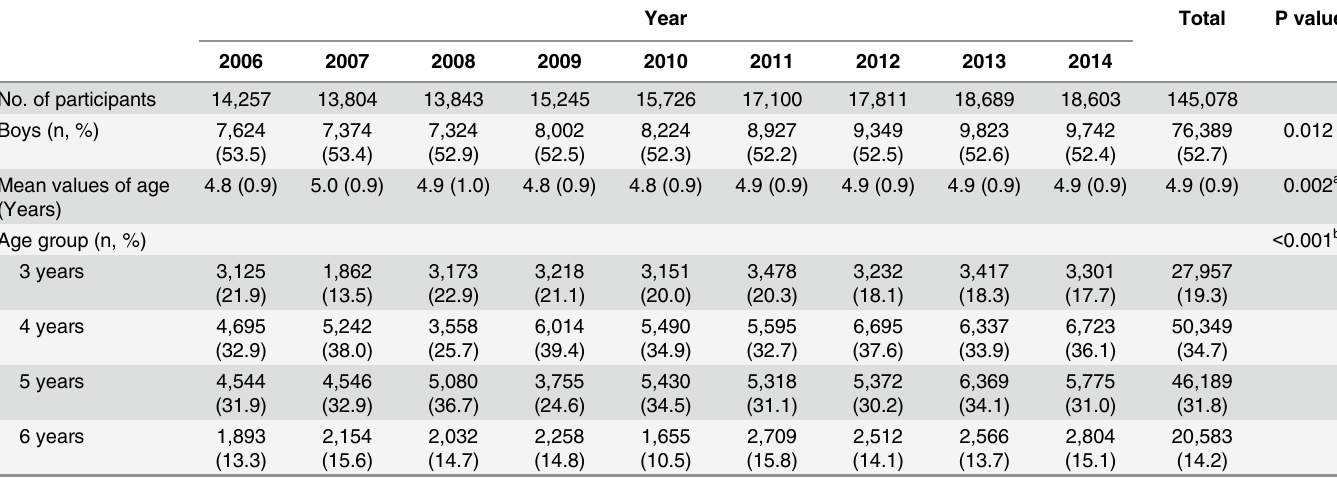
Table 1. Sample sizes by sex and age in the children at 3 – 6 years in Tianjin from 2006 to